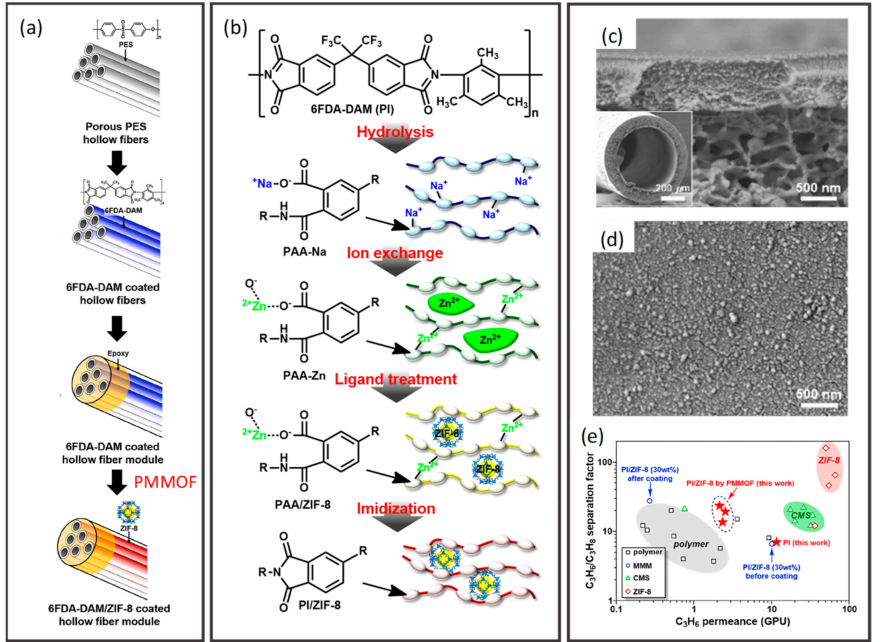
Figure 14. Schematics on ( a ) preparation of 6FDA-DAM/ZIF-8 coated hollow fiber module and ( b ) PMMOF process. SEM images of 6FDA-DAM/ZIF-8 hollow fiber membrane: ( c ) magnified cross-section and ( d ) top view. Inset image in ( c ) represent the overall cross-section of the membrane. ( e ) Comparison on C 3 H 6 permeance and C 3 separation factor of 6FDA-DAM/ZIF-8 hollow fiber mod- ules with other works. Reprinted/adapted with permission from Ref. [503]. Copyright 2020,